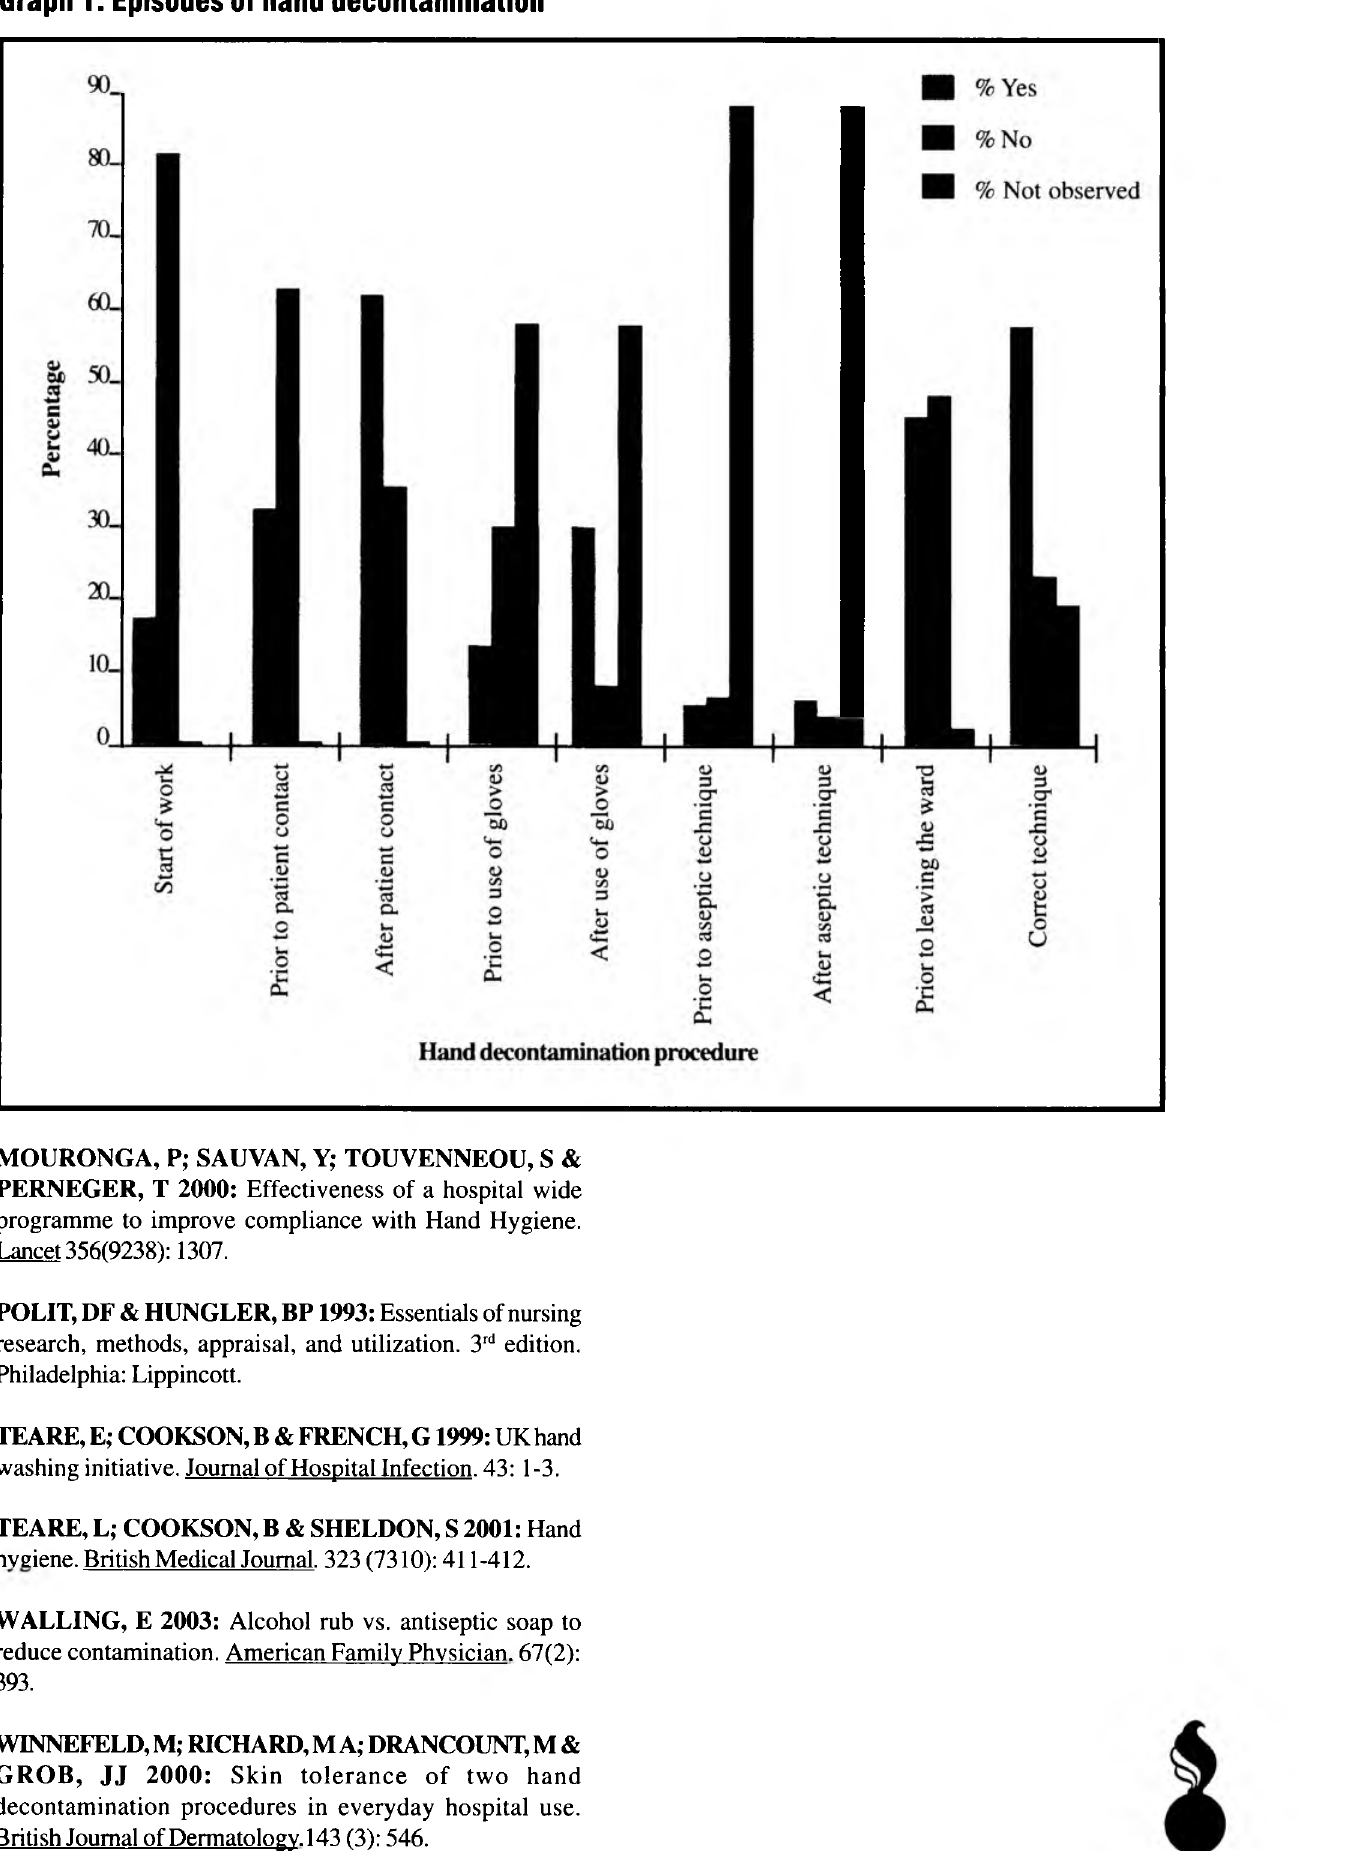
Graph 1 : Episodes of hand